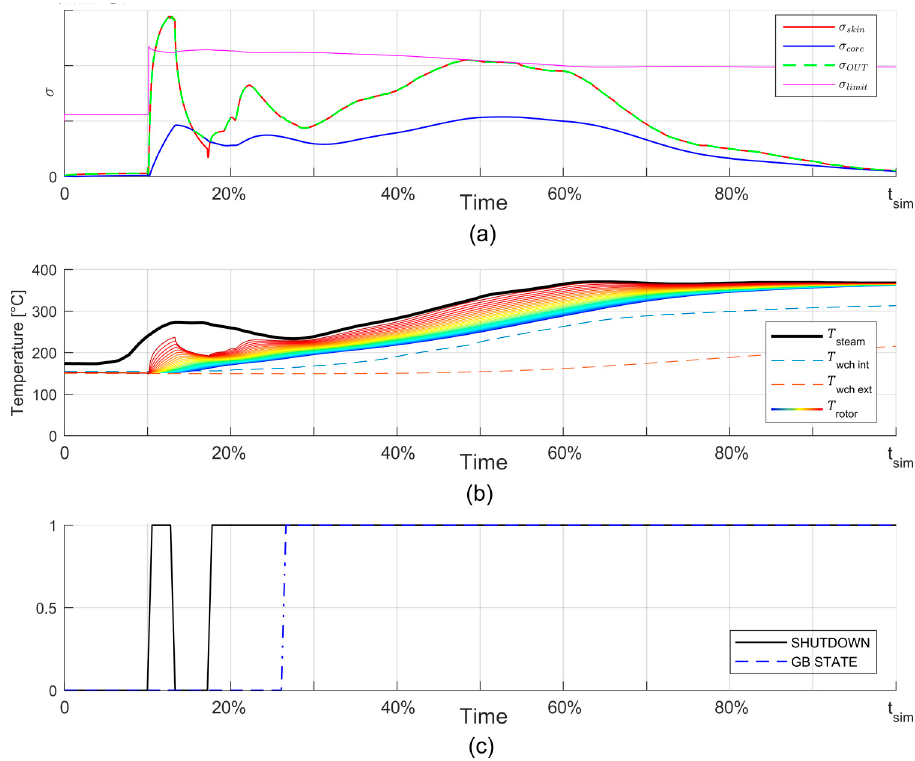
Figure 19. Example of application of NMPC to the startup of a LP turbine, stress conditions, steam and rotor temperatures, and startup state. Stress trends ( a ); temperature of the steam, wheel chamber and rotor ( b ); startup and generator breaker commands ( c ).